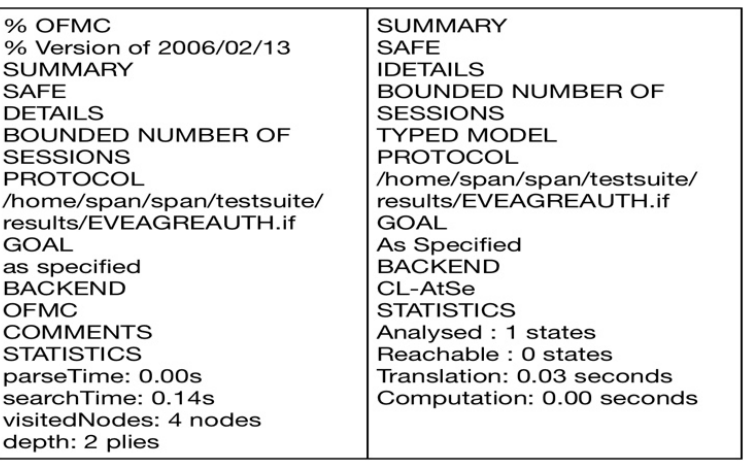
Figure 16. Reauthentication AVISPA simulation results.